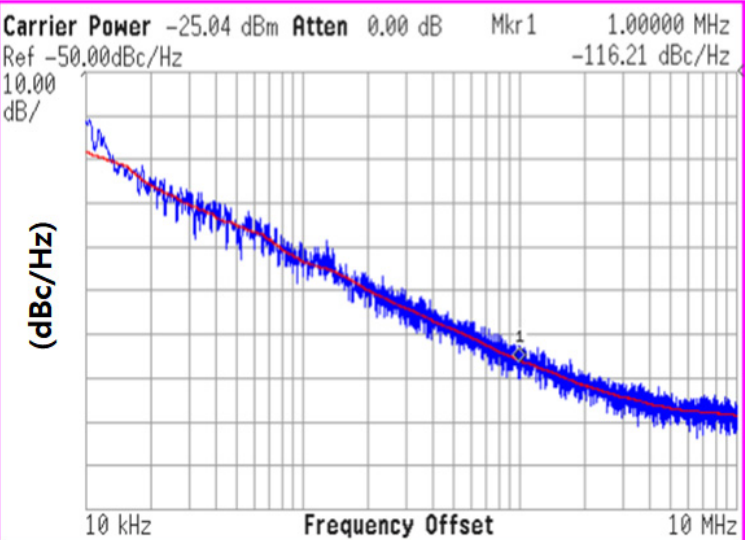
Figure 9. Measurement result of phase noise in an NDCO. Table 1. Summary of performances of designed DCOs and comparison with previous works. FoM, figure-of-merit.